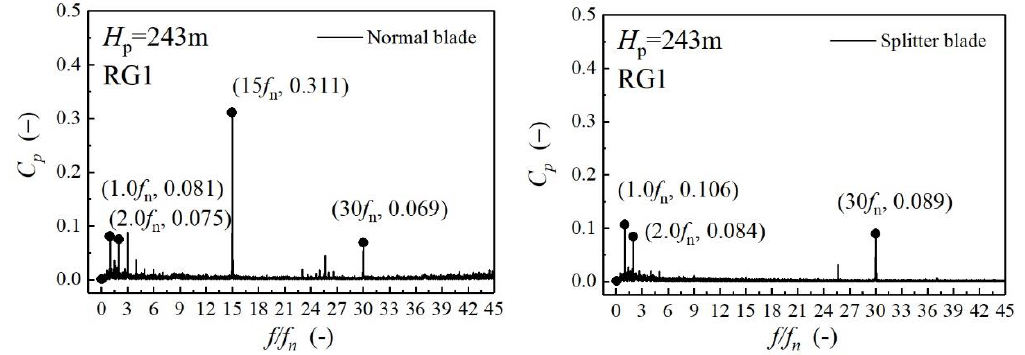
Figure 17. Frequency characteristics in vaneless space at 243 m head.